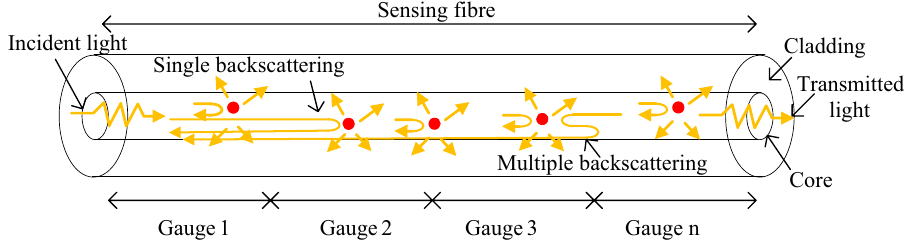
Figure 1. A schematic of the theoretical model. The red dots show the gold nanoparticles in the core of the sensing fibre in random